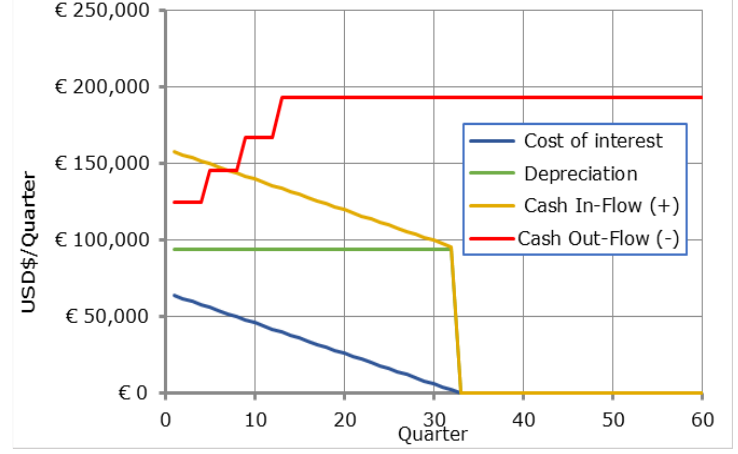
Figure 4. Cash-flow, IRR = 7.68%, NPV = 6,000,000 USD$, scenario D. The cash outflow, is defined as a function of the installed propulsion power, type of fuel and generated, price of the fuel and taxes related to 𝐹𝐹𝐴𝐴𝐶𝐶ℎ 𝑐𝑐𝑜𝑜𝑡𝑡𝑛𝑛𝑛𝑛𝑐𝑐𝑜𝑜 CO 2